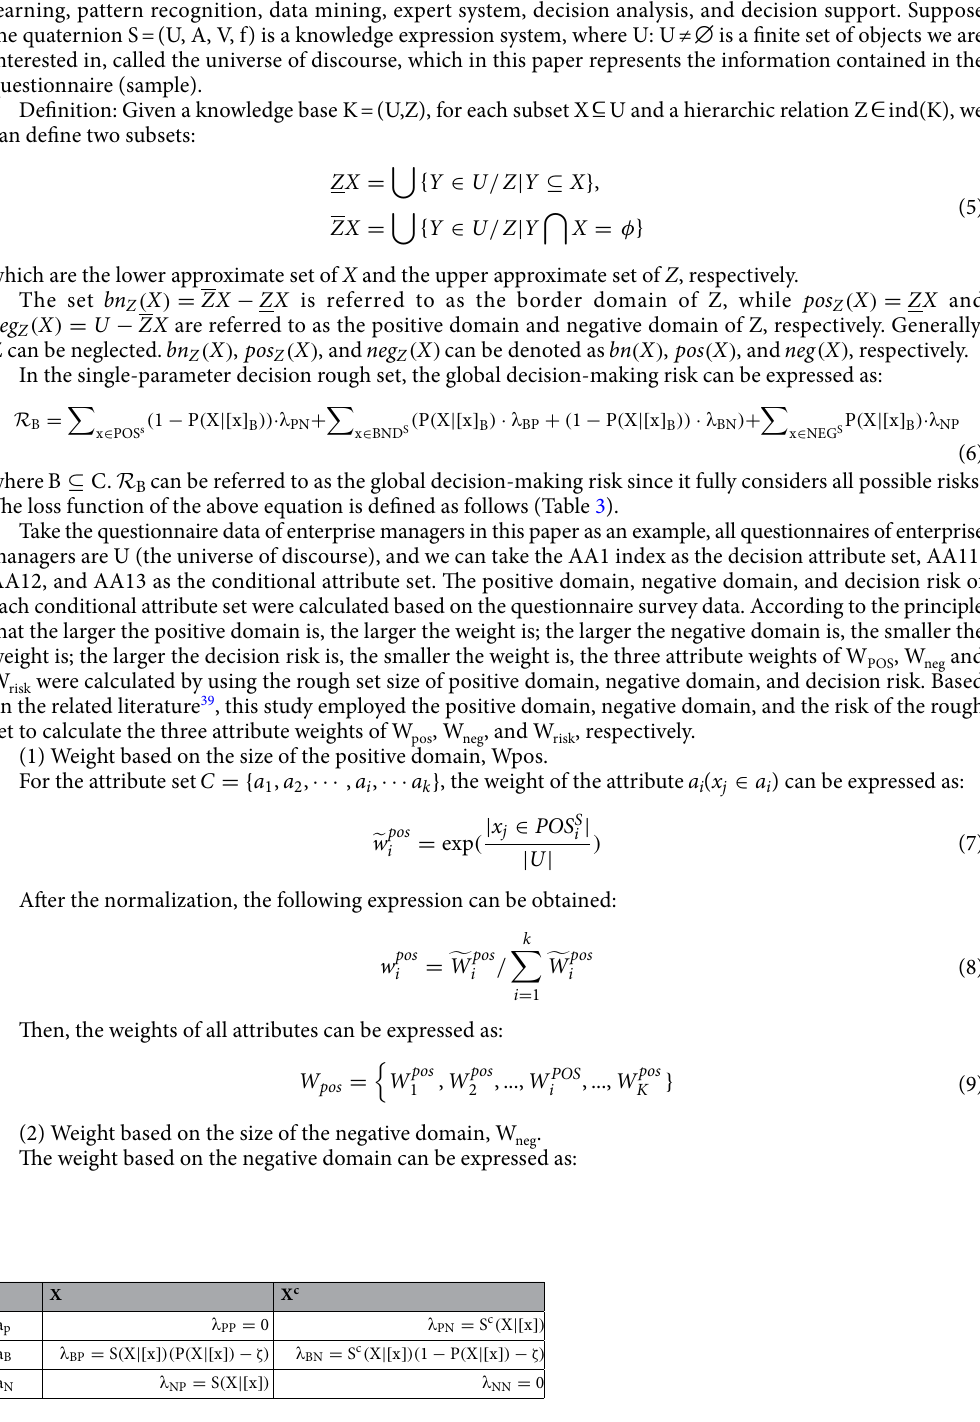
Table 3. Data-driven loss function